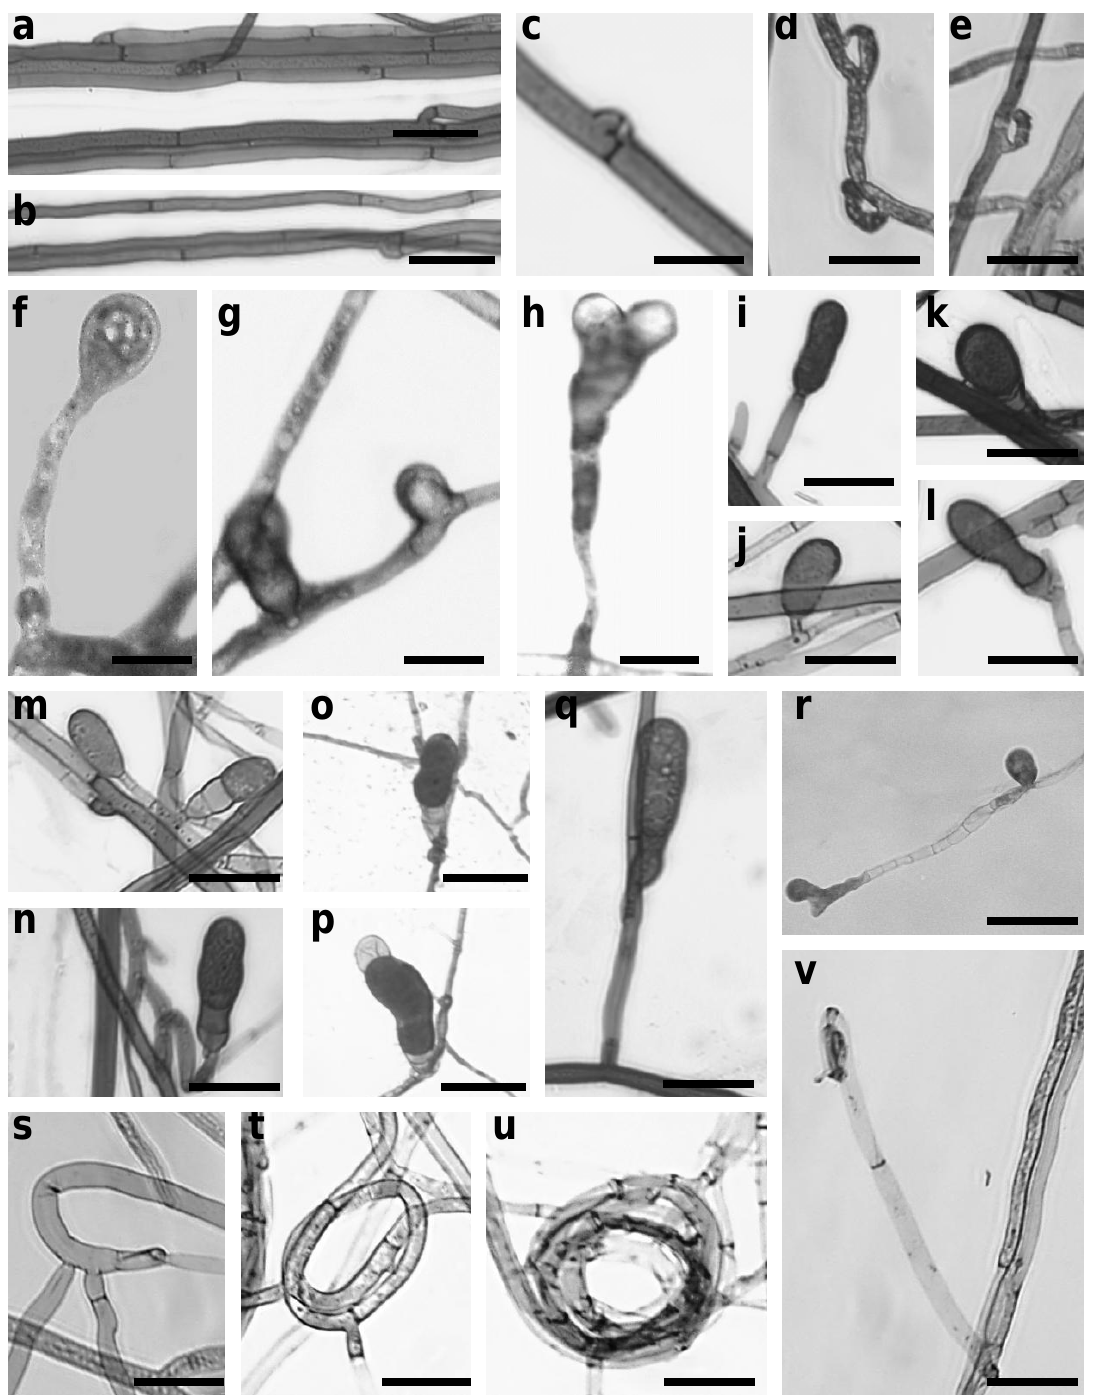
Figure 8. Micromorphological structures in C. aff. radians strains: (a, b) clampless mycelia, (c–e) pseudoclamps, (f–h) hyphal swellings, and (i-r) allocysts of different ages. Older allocysts are accompanied by (m, q, r) secondary septa, (s-u) formation of hyphal loops, and (v) mycelial cystidia; (a–c, f–q, t, u ) strains 1-2PS and (d, e, r, s, v) 1-1C. Size bars correspond to (c, f–h) 10 µm, (d, e, i–n, q–v) 20 µm, and (a, b, o, p) 50 µm,